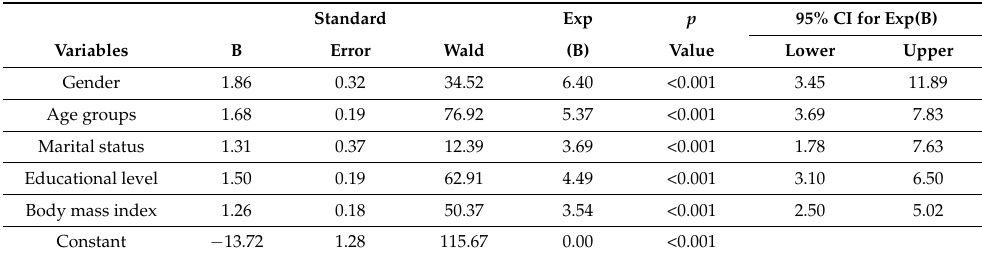
Table 4 shows the binary logistic regression model for predictors of participants’ awareness of IBS. The odds ratio, i.e., Exp(B) for the significant independent variables was 6.4 for the participants’ gender, 5.37 for their age groups, 4.49 for their qualification, 3.69 for their marital status, and 3.54 for their body mass index. All the independent variables included had a statistically significant association with participants’ awareness of IBS ( p < 0.001). Table 4. Binary logistic regression for independent variables affecting awareness of